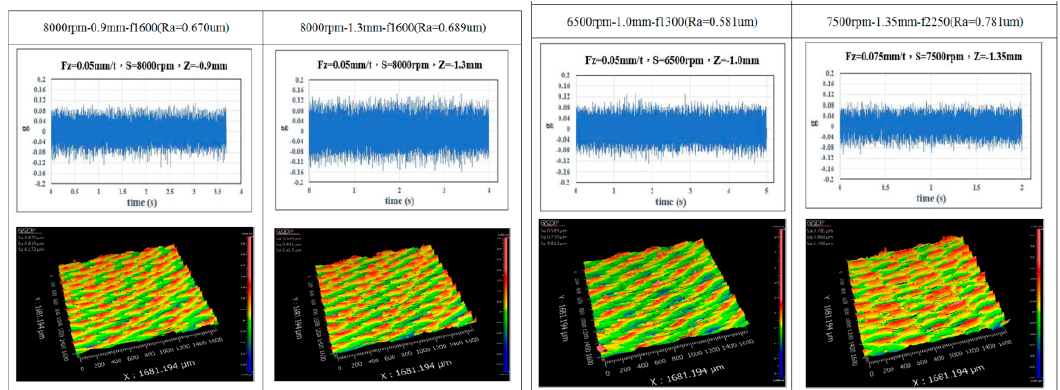
Figure 14. Morphologies of the machined surfaces under various cutting parameters.